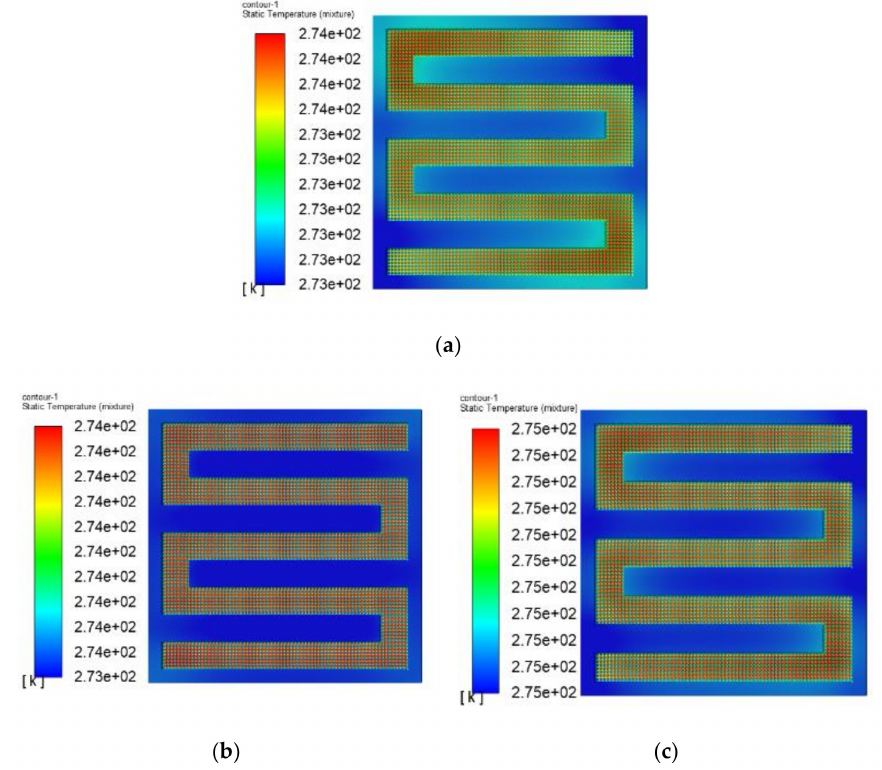
Figure 24. The fuel cell temperature contours with pore diameter = 0.3 mm at di ff erent times; ( a ) t = 28 s, ( b ) t = 40 s, ( c ) t = 44